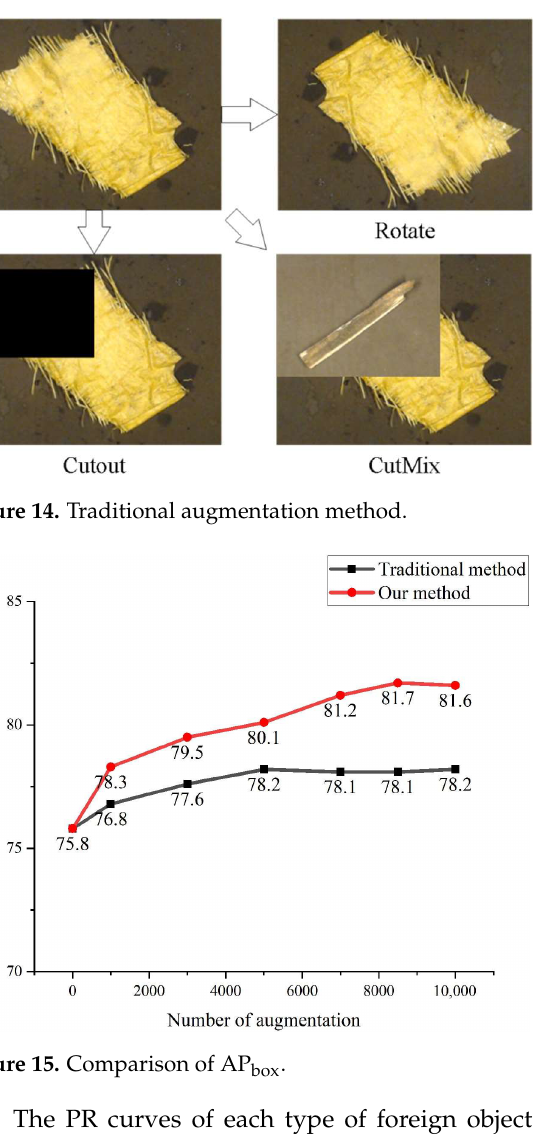
Figure 14. Traditional augmentation method.